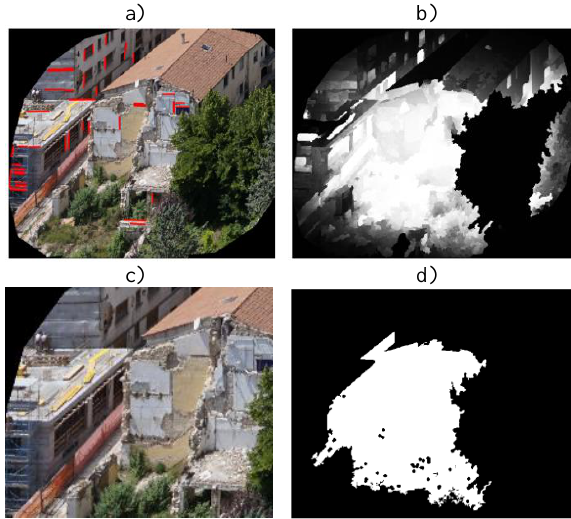
Figure 11 Results of the façade line segments and salient object map: a) façade line segments overlaid in buffered façade patch, b) real-time salient object, c) final refined facade patch, d) binary image of the salient object detection in b)